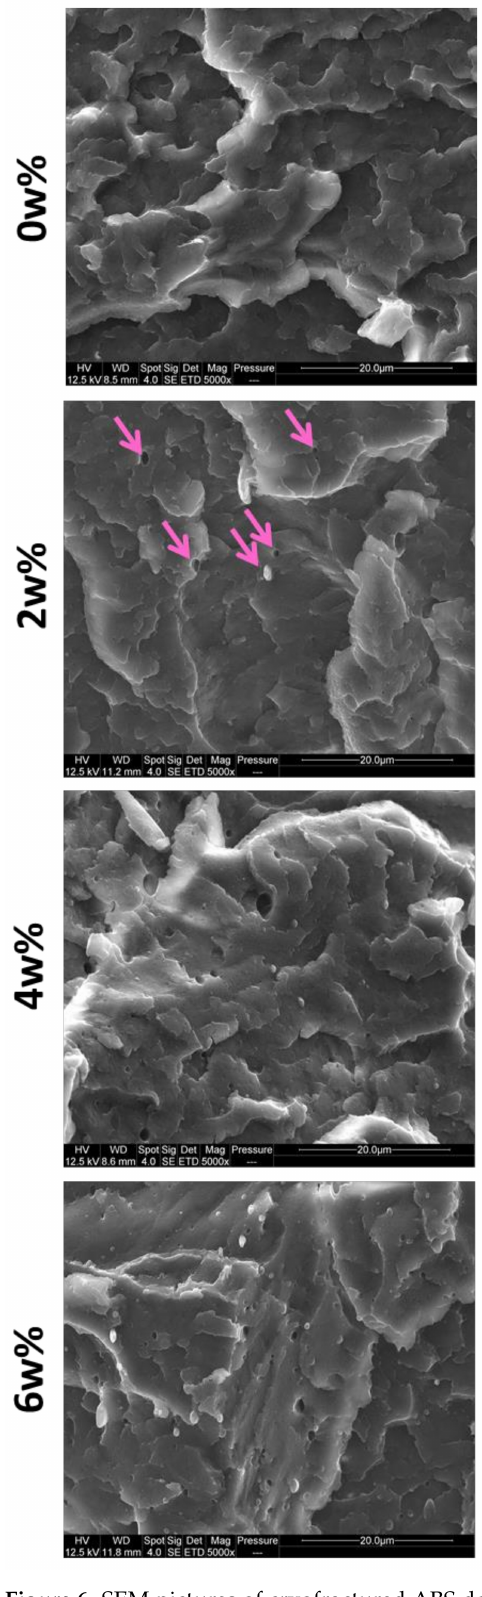
Figure 6. SEM pictures of cryofractured ABS dogbones contaminated at 0, 2, 4 and 6 wt% of PP— 5000 ×